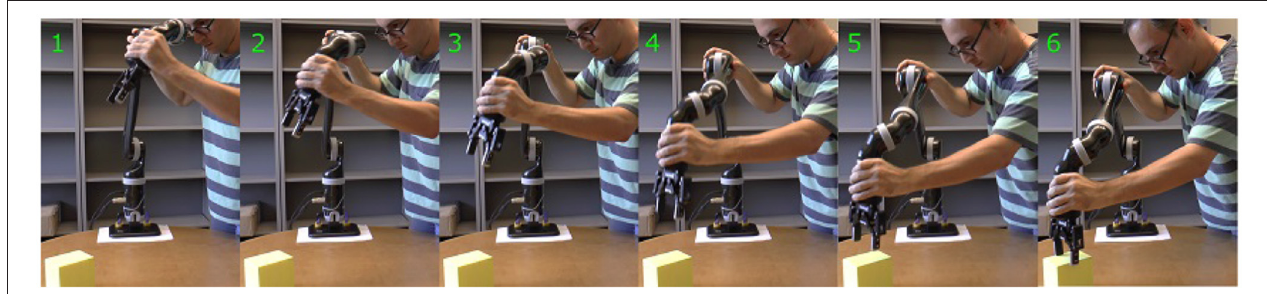
FIGURE 3 | One of the authors of the paper demonstrating a reaching skill using kinesthetic teaching. Captured task-space poses of the end-effector are used as input for learning.